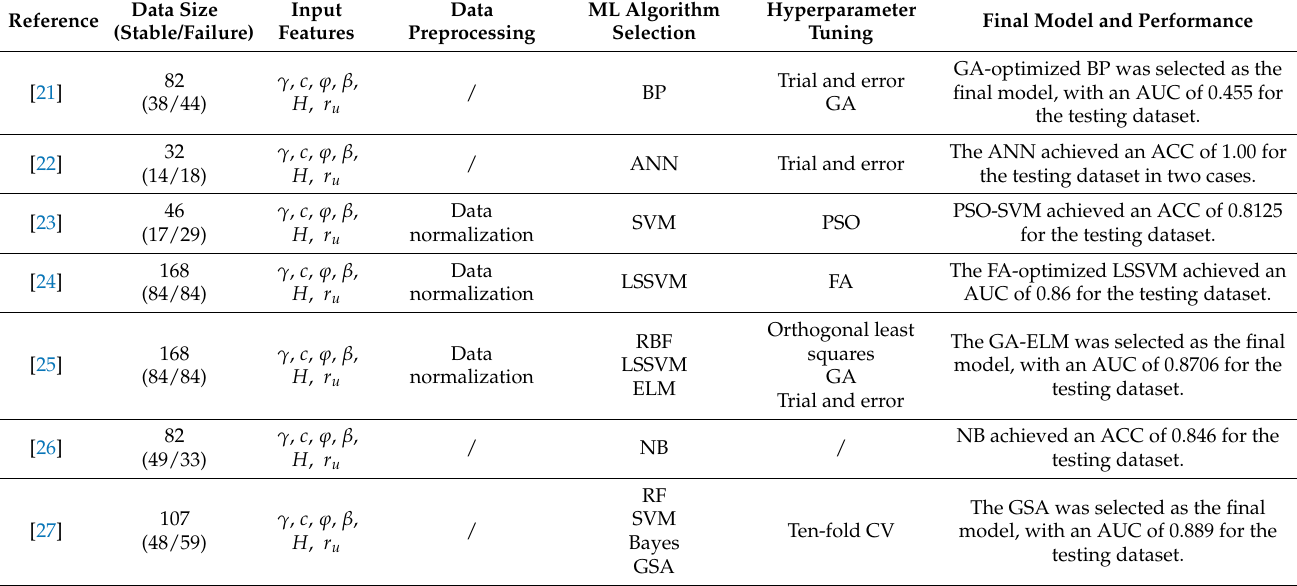
Table 1. Summary of the slope stability assessment of circular mode failure using